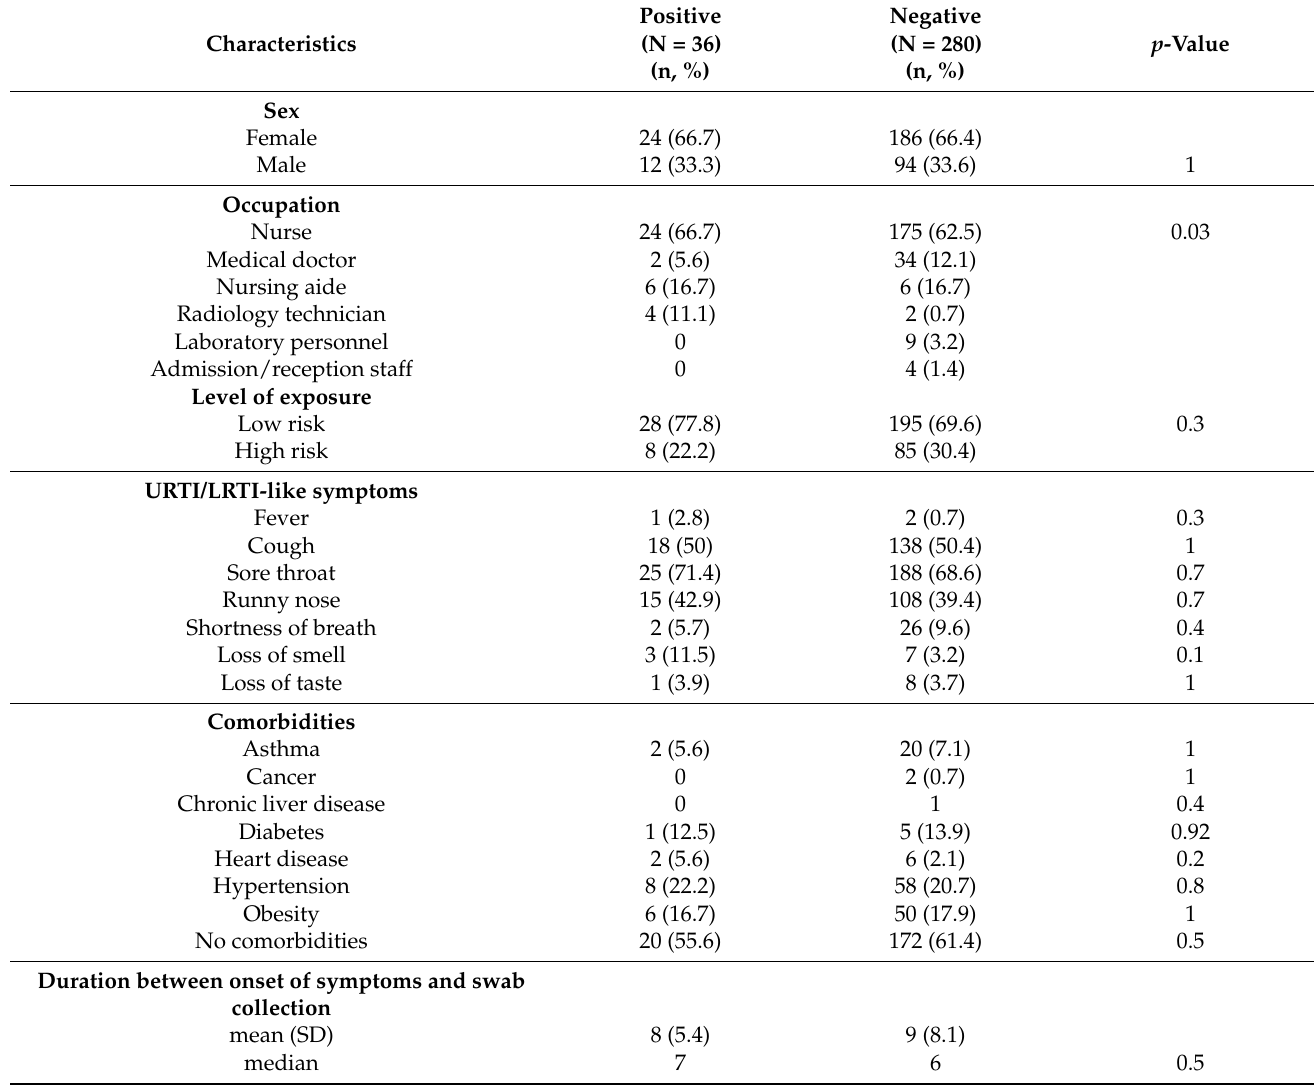
Table 3. Comparison of characteristics and signs and symptoms of HCWs suspected to have COVID-19 who tested positive and negative for the additional respiratory viral panel